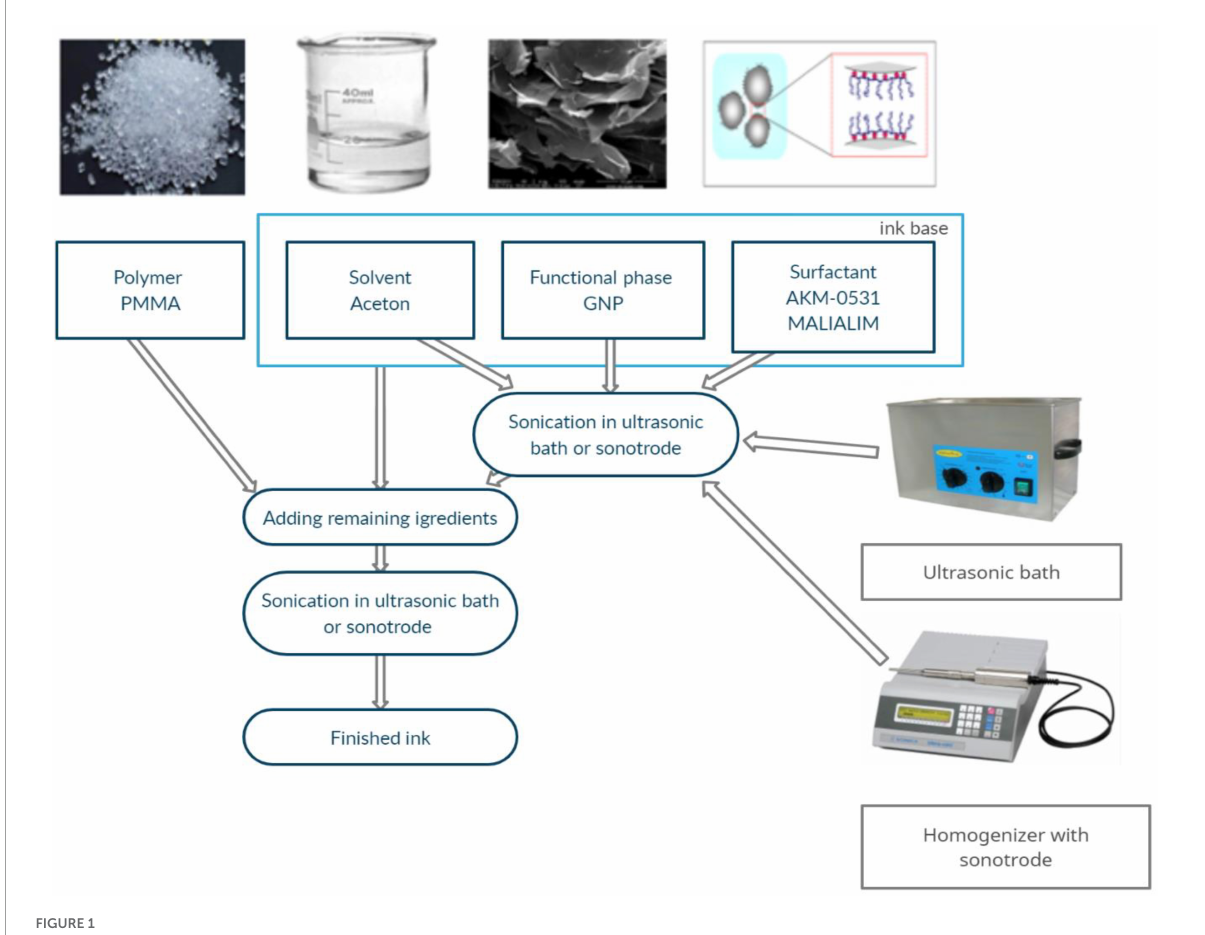
FIGURE1 Graphene ink fabrication scheme (Dybowska-Sarapuk et al., 2020).